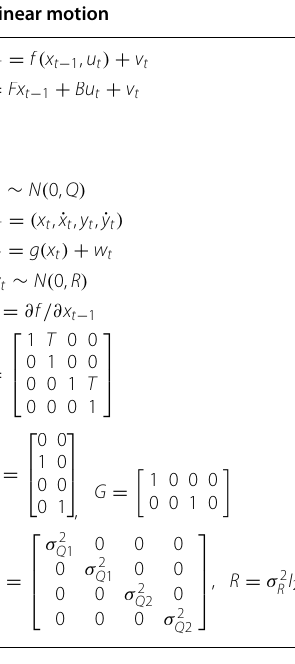
Table 2 Model terms of the mobile robot examples Linear motion Nonlinear